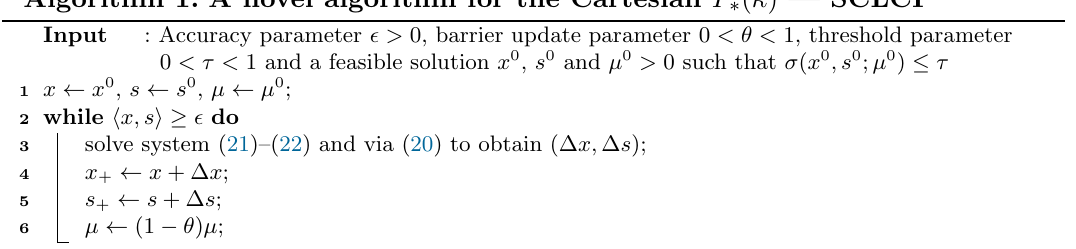
Algorithm 1: A novel algorithm for the Cartesian P